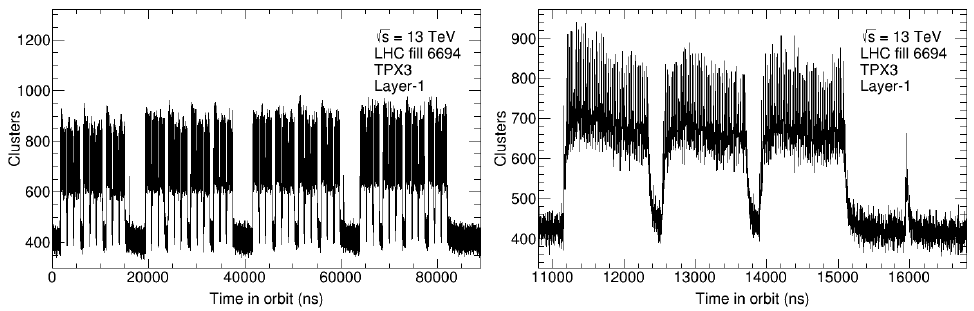
Figure 70. Bunch structure of individual bunch collisions observed with TPX3 for layer 1. Left : 15 LHC bunch trains are visible, as well as two isolated colliding bunches at 15,950ns and 60,490ns orbit times. Right : details for the orbit time range from 10,800ns to 16,800ns are shown. In this time range, one bunch train with two short gaps and one isolated colliding bunch are observed. The data are integrated over LHC fill 6694. Taken from Ref. [18].